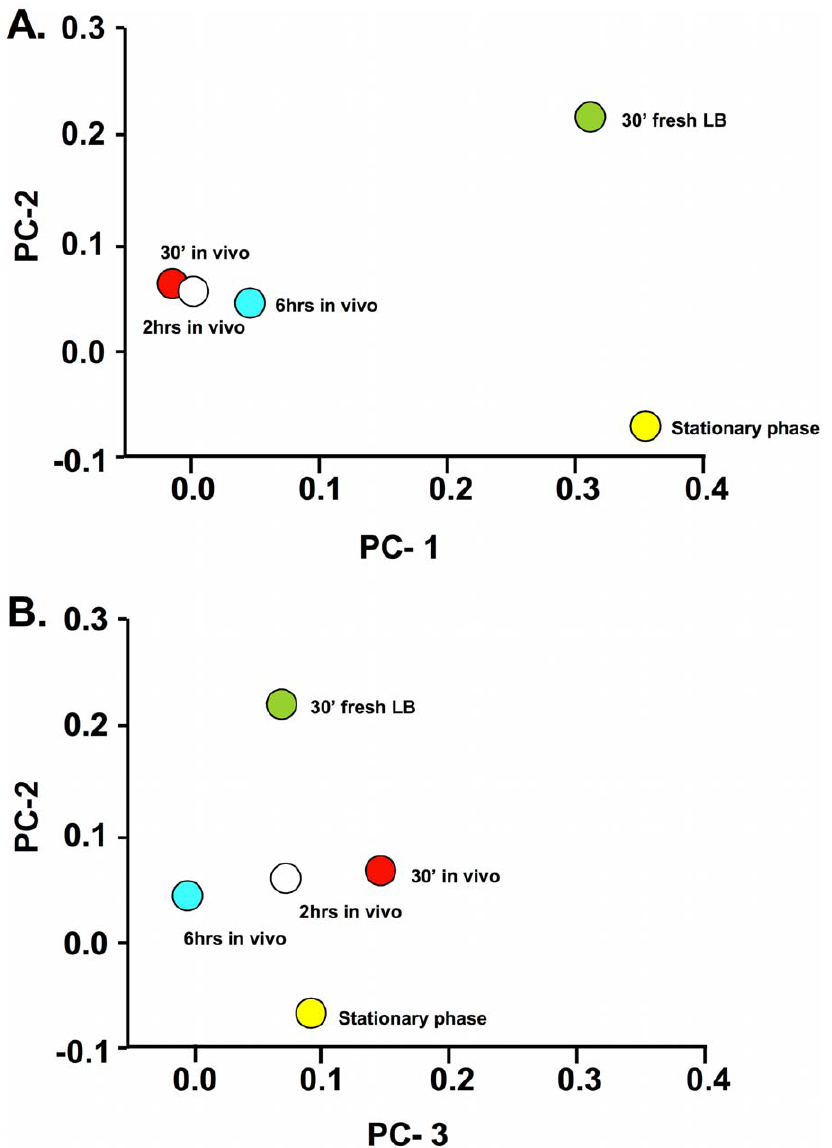
Figure 1. Principle component analysis based on growth condition from Saur2A GeneChip mRNA hybridization data. Mean centering and scaling was used to transform the resulting eigenvectors into indices of explained variability. The axis scale indicates fraction of the total variance explained by the individual principle component plotted on that axis. Each point on the graph is labeled with its particular growth condition. Panel A: Principle component 1 vs. principle component 2. Panel B: Principle component 2 vs. principle component